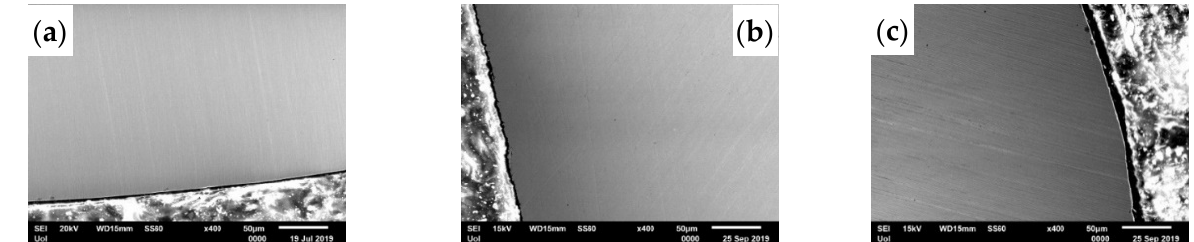
Figure 3 illustrates cross-sectional micrographs of 316L rebars removed from concrete cubes with fly ash (0, 20, and 25% in cement) and Inhibitor B having undergone salt fog test for a period of four months at low magnifications. A fine surface state is demonstrated. High magnifications are displayed in Figure 4.